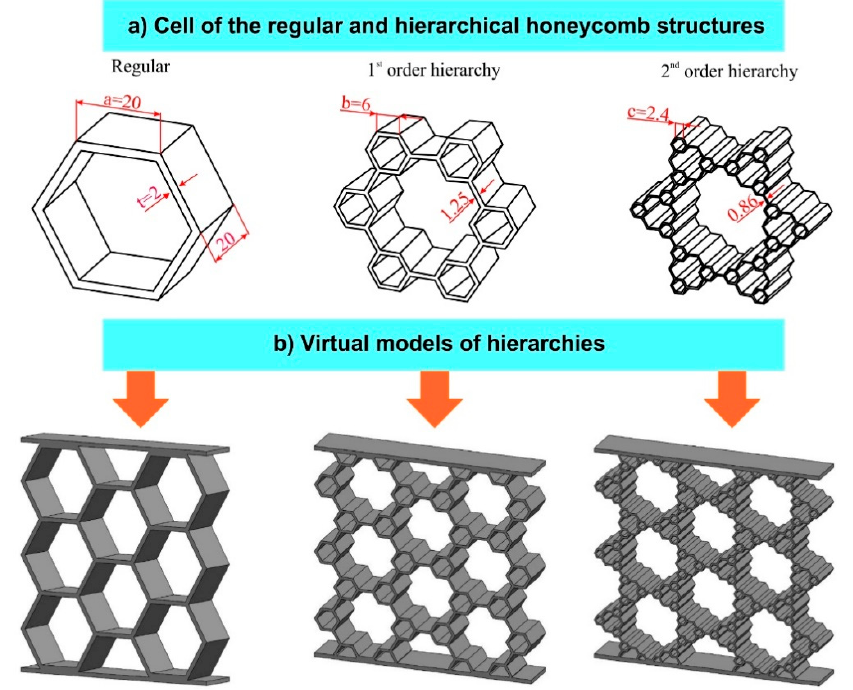
Figure 1. Hierarchical honeycomb structures: ( a ) cell of the regular and hierarchical honeycombs and ( b ) virtual models of hierarchies.